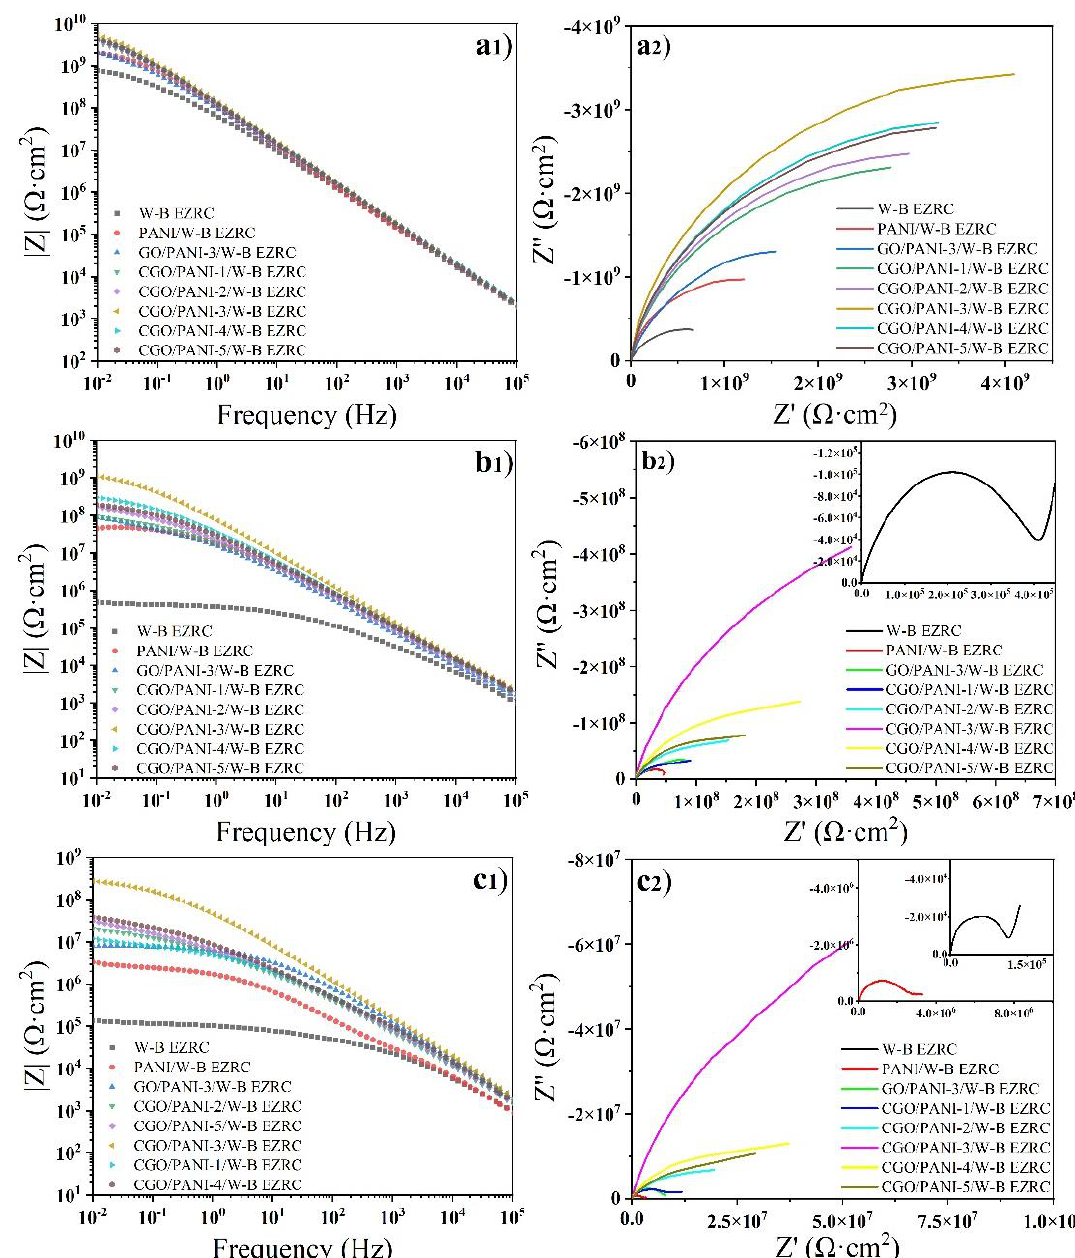
Figure 5. Bode plots and Nyquist plots of W-B EZRC, PANI/W-B EZRC, CGO/PANI-1/W-B EZRC, CGO/PANI-2/W-B EZRC, CGO/PANI-3/W-B EZRC, CGO/PANI-4/W-B EZRC, CGO/PANI-5/W-B EZRC soaked in 3.5 wt% NaCl for 2 h ( a 1 , a 2 ), 168 h ( b 1 , b 2 ), 528 h ( c 1 , c 2 ).